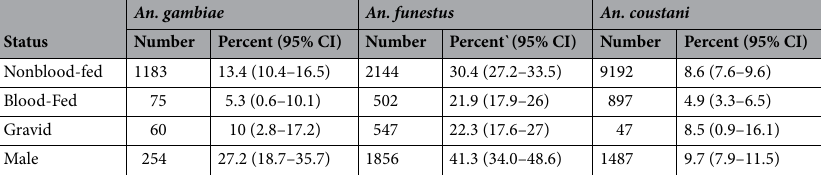
Table 3. Frequency of sugar feeding by species, sex and abdominal status.